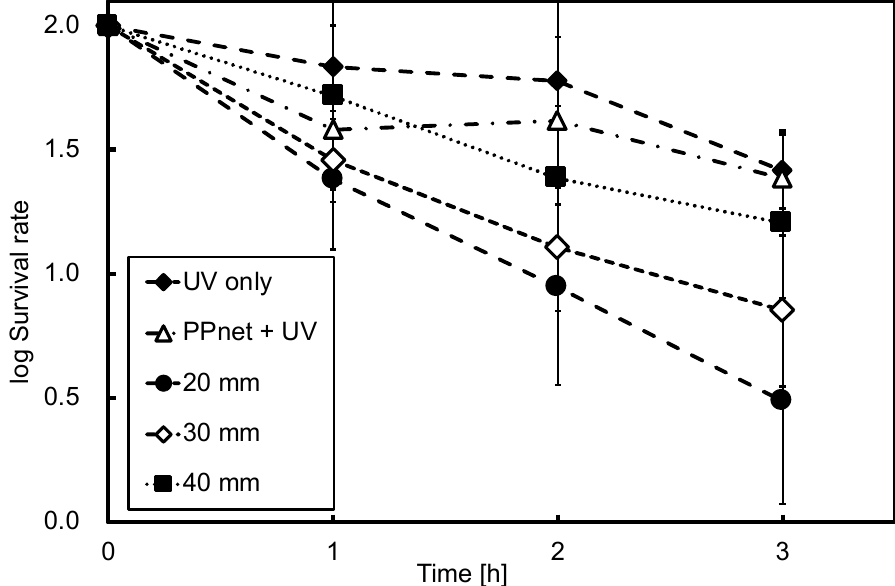
Figure 9. Photocatalytic sterilization of water containing E. coli at various water depths.